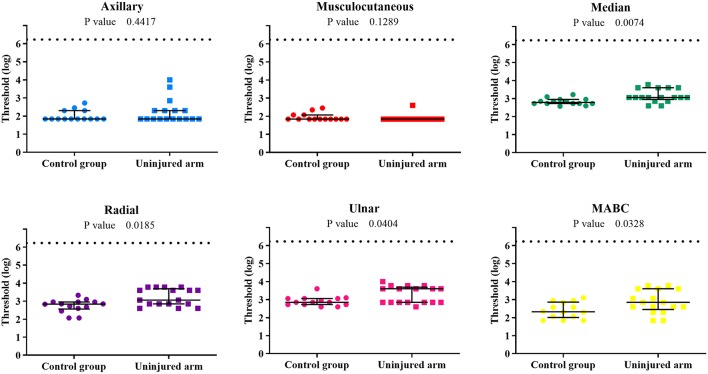
Individual sensory threshold values of the 6 PEIs of the control group compared to the BPI patients' uninjured upper limb. Lines represent the median values and the interquartile ranges of each group. P-values of the difference between groups (control × uninjured) are presented in each graph. The broken line represents the top limit of the set of monofilaments (6.20). ● = control (n = 14) and ■ = BPI patients (n = 17).